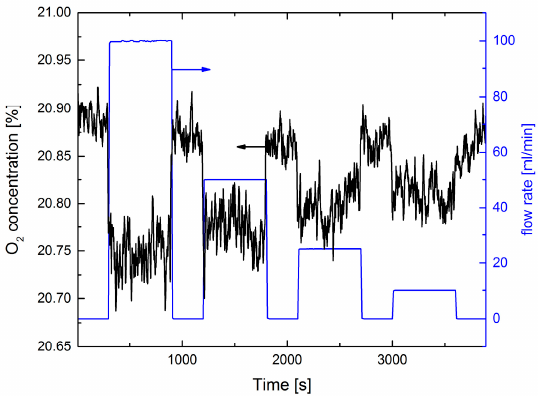
Figure 8. Static standoff N 2 detection via an O 2 measurement. The distance between laser and leak plate was 55 cm. The N 2 flux was stepwise reduced from 100, 50, 25, to 10 mL/min (blue curve, right ordinate scale).